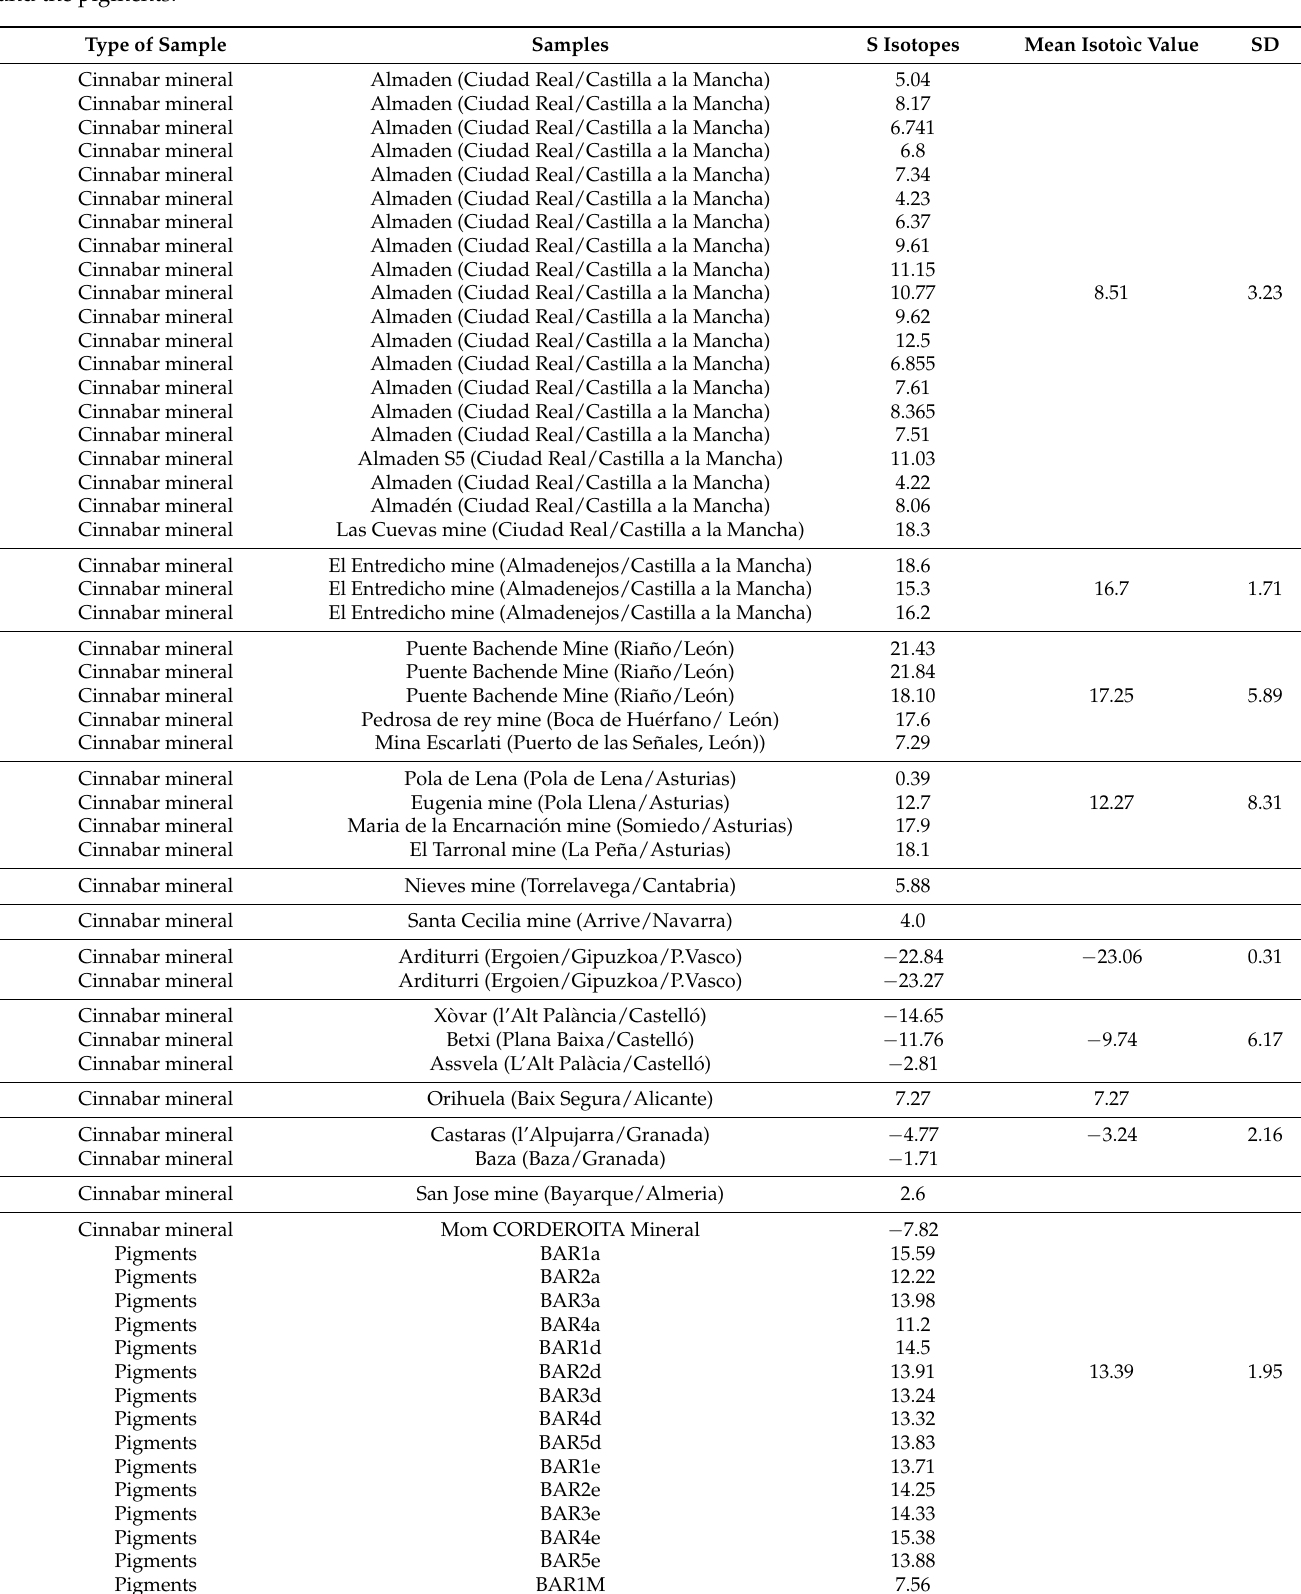
Table 1. List of the samples and the raw isotopic values of S isotopes and the mean and standard deviation for each one of the mines and the